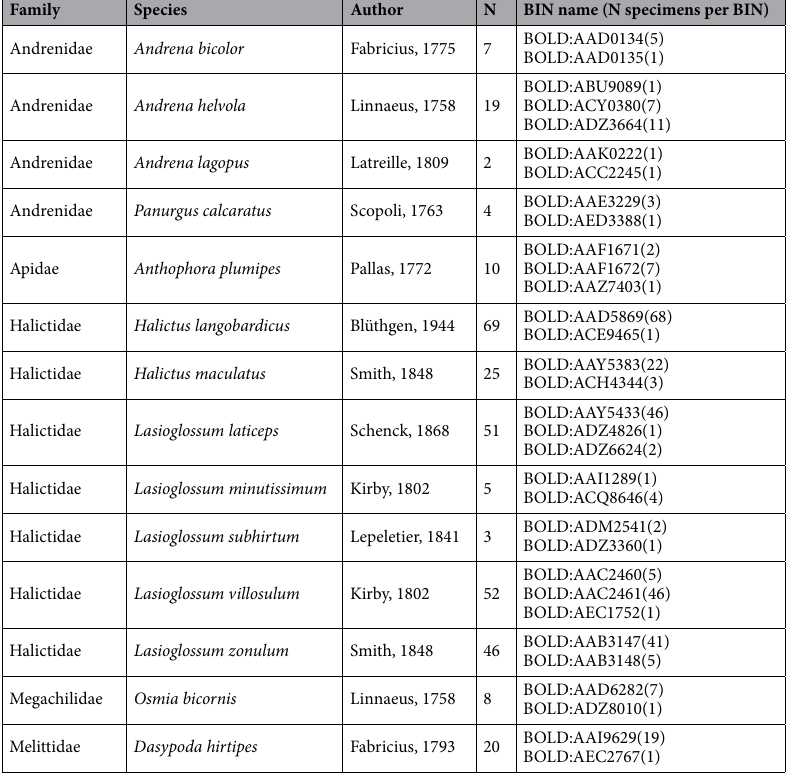
Table 2. Sampled bee species barcodes assigned to multiple BINs by the BOLD system database.